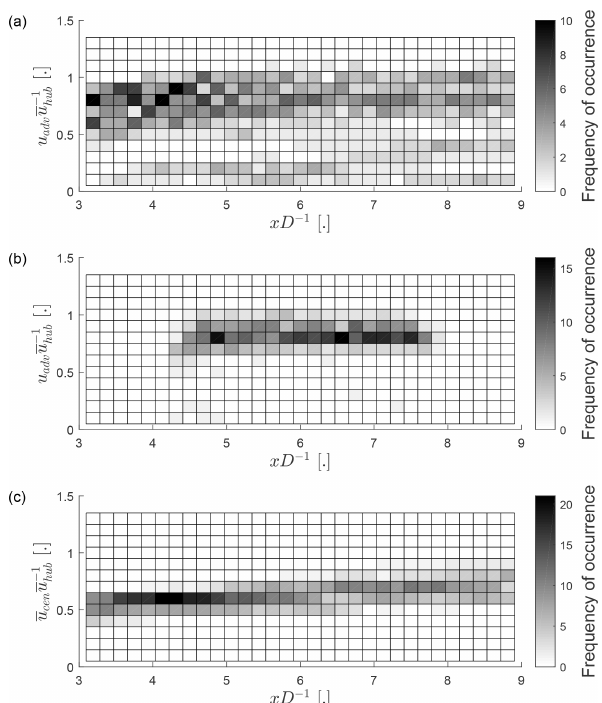
Figure 9. Frequency of occurrence of the advection velocity based on the cross-correlation between v ( t ) and y com ( t ) (a) , the advection velocity based on the cross-correlation between y com ( t ) at two dif- ferent downstream distances (b) , and the wake centre velocity based on the temporal average of u r ( x,y com ,t ) (c) normalized by u hub . The absence of data in (b) for xD − 1 < 4 . 5 and xD − 1 > 7 . 5 is caused by the error threshold for u adv (Fig. 3).